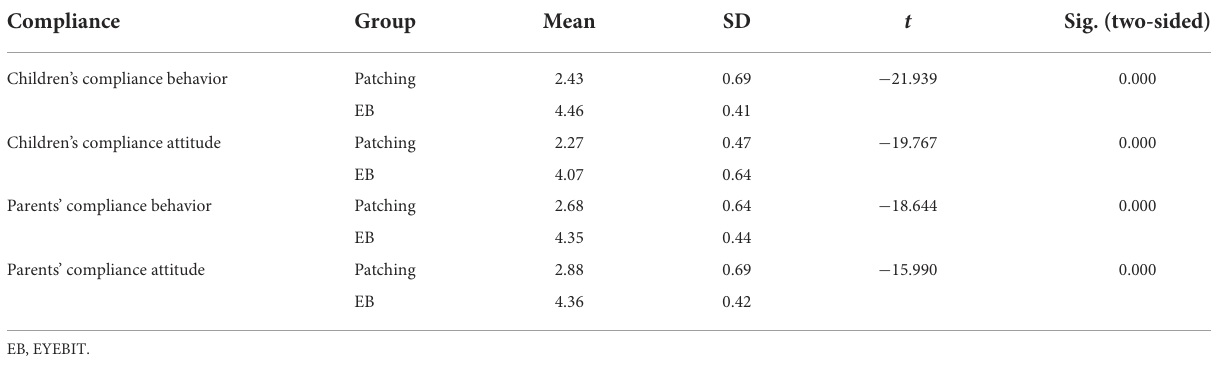
TABLE 4 Compliance score differences between the two training methods.